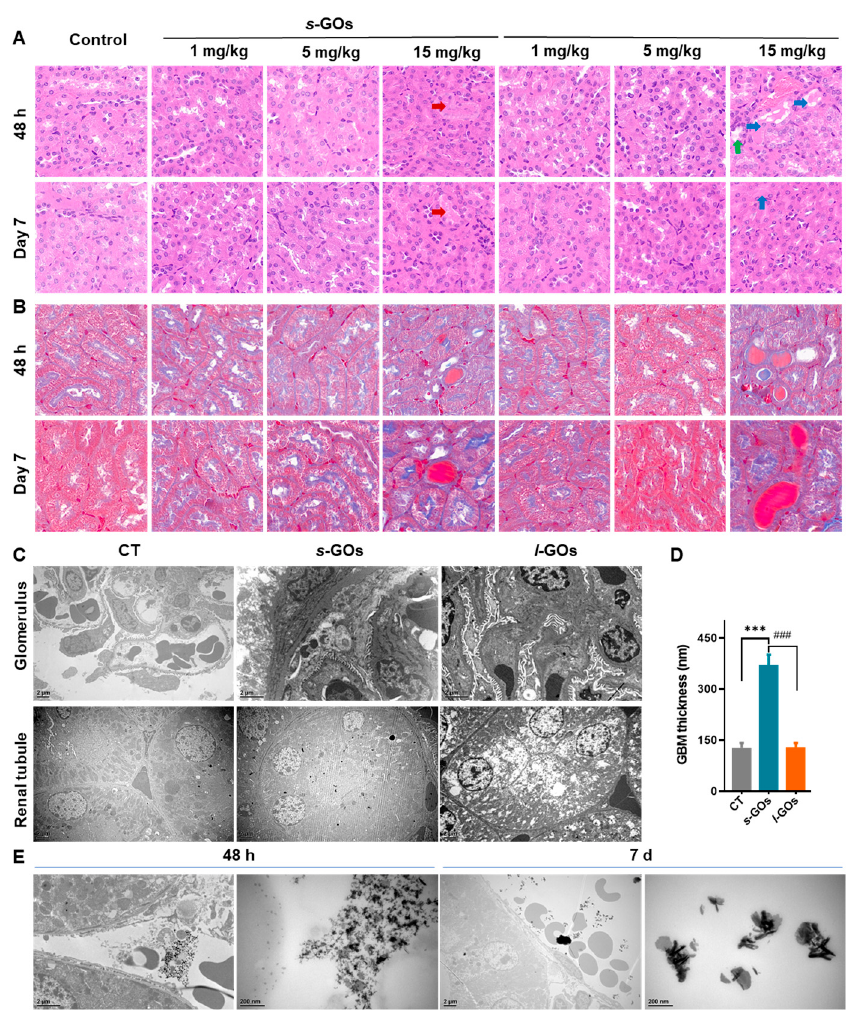
Figure 3. ( A ) Representative light microscopy images of H&E ‐ stained kidney sections harvested from s ‐ GO − and l ‐ GO − treated mice at 48 h and day 7 after i.v. injection. There was a moderate dilatation of the tubules containing hyaline (protein) casts in the renal tubules at 48 h and day 7 after 15 mg/kg s ‐ GO and l ‐ GO administration. No obvious pathological changes were found in the kidneys of 1 and 5 mg/kg GO − treated mice. ( B ) Masson’s trichrome staining of kidney tissues of s ‐ GO − and l ‐ GO − treated mice at 48 h and day 7 after i.v. injection. No evidence of fibrosis was observed. ( C ) TEM micrographs from glomerulus and renal tubule at day 7 after mice i.v. injection of 15 mg/kg bw s ‐ GOs and l ‐ GOs. ( D ) Statistical results of glomerular basement membrane thickness. Red arrow: necrosis of renal tubular epithelial cells. ( E ) TEM images show l ‐ GOs deposited in the renal interstitial capillaries after i.v. injection of 15 mg/kg bw at 48 h and 7 days. Green arrow: dilatation of the tubules. Blue arrow: cast formation. *** p < 0.001 for GO − treated vs. the control group; ### p < 0.001 for s ‐ GO − vs. l ‐ GO − treated group.